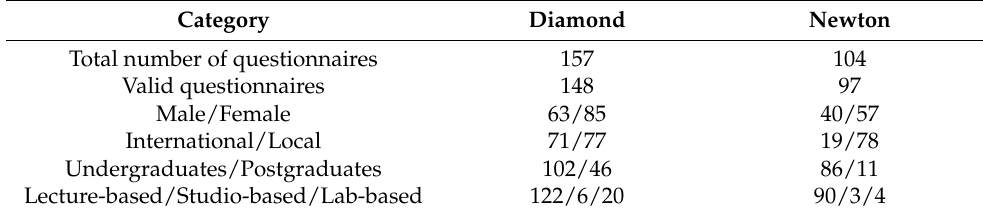
Table 3. Personal background information of two case studies by